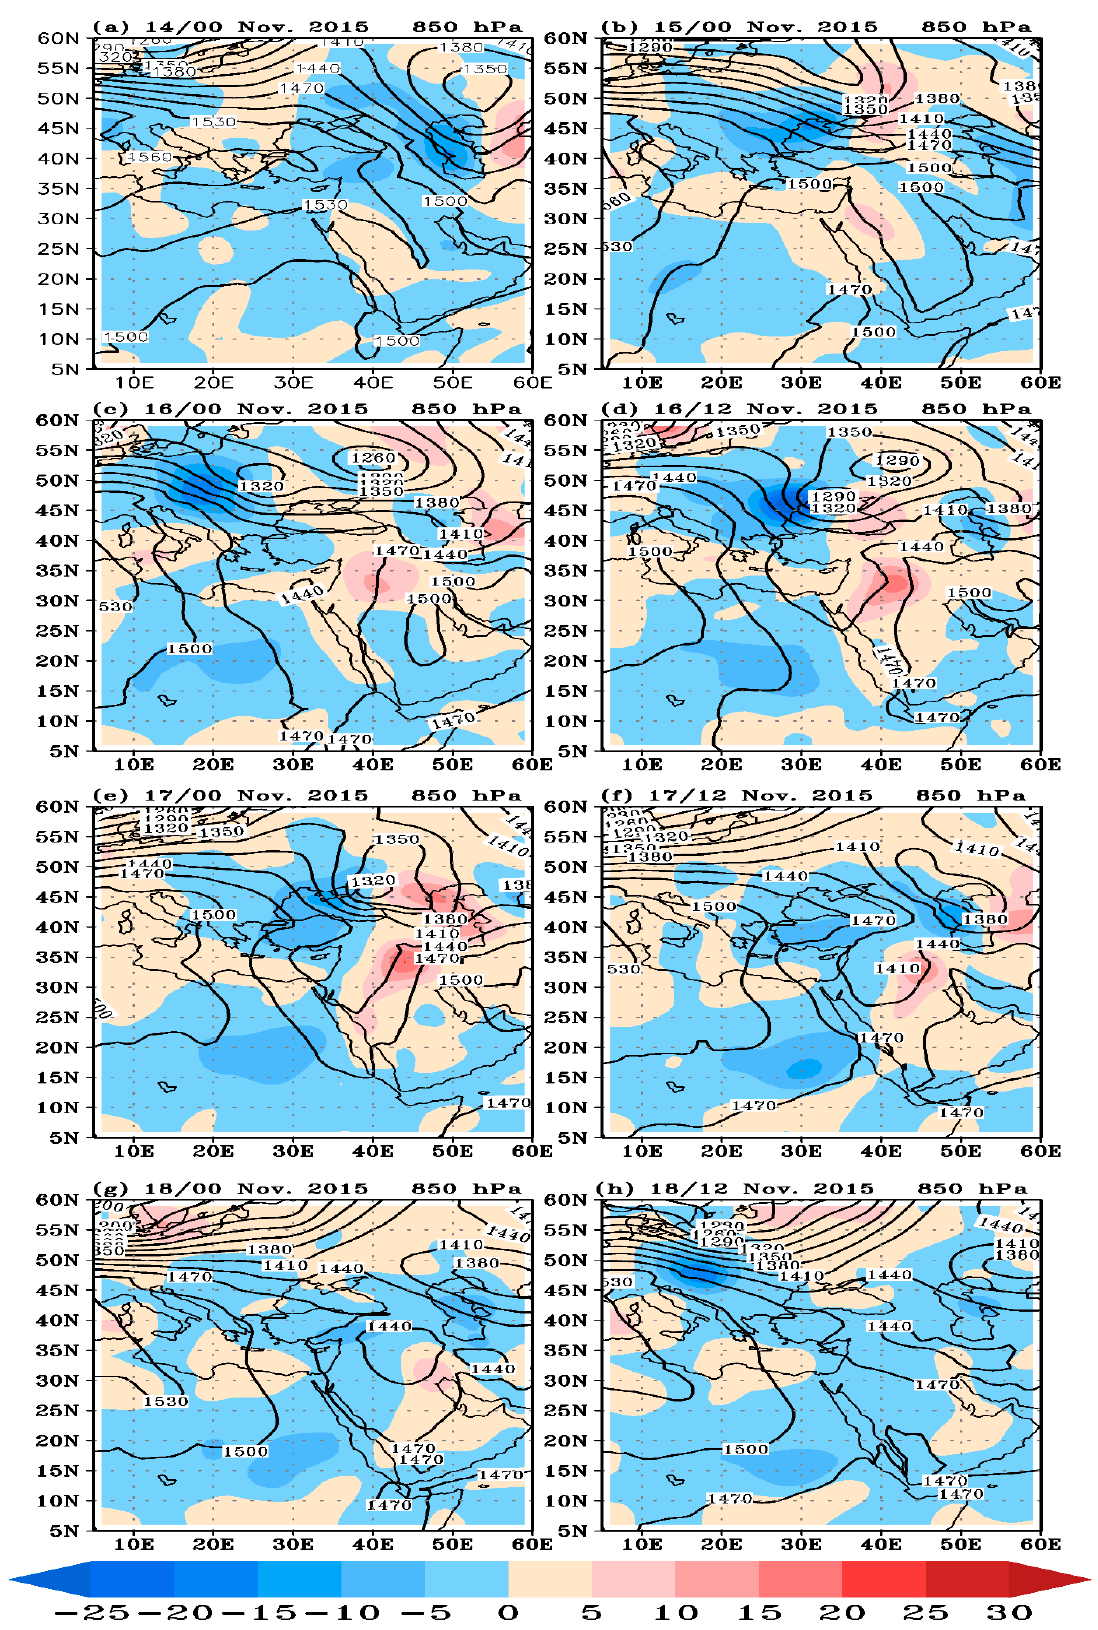
Figure 4. 850 hPa geopotential height with 30 m contour intervals (black solid lines) and horizontal advection of temperature (red and blue shaded areas) ( a – h ) for the period 14–18 November 2015.